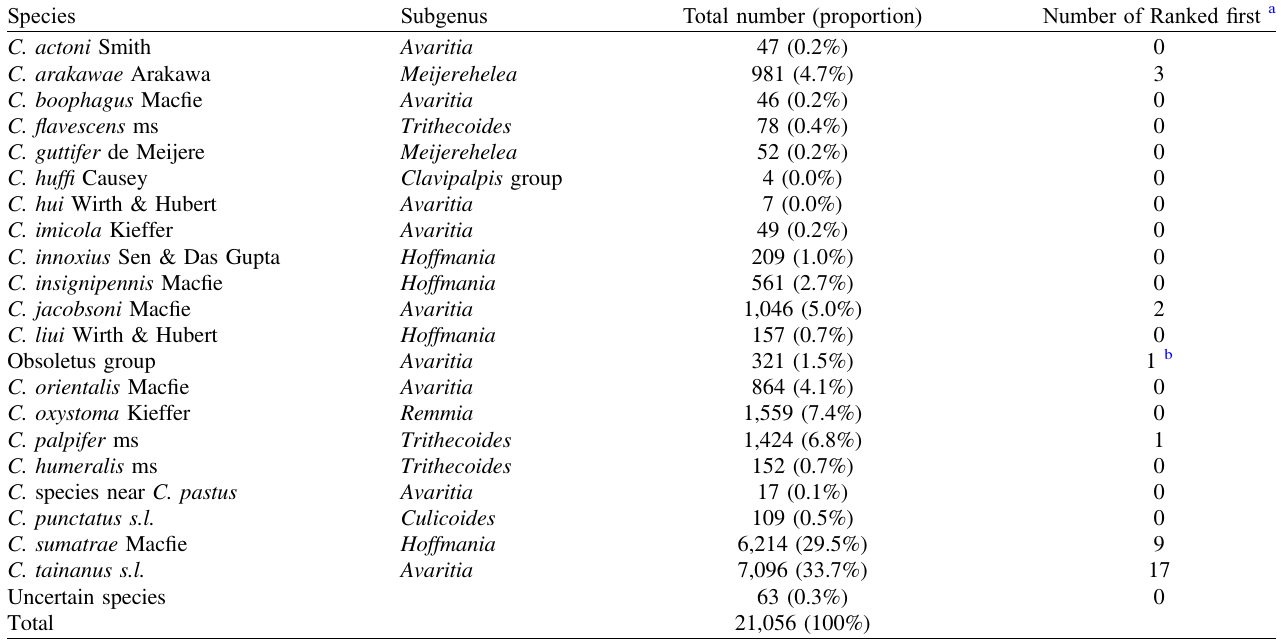
Table 1. Abundance of Culicoides species collected in UV traps at Wulong, Shizong, Yunnan Province, China between May 2020 and May